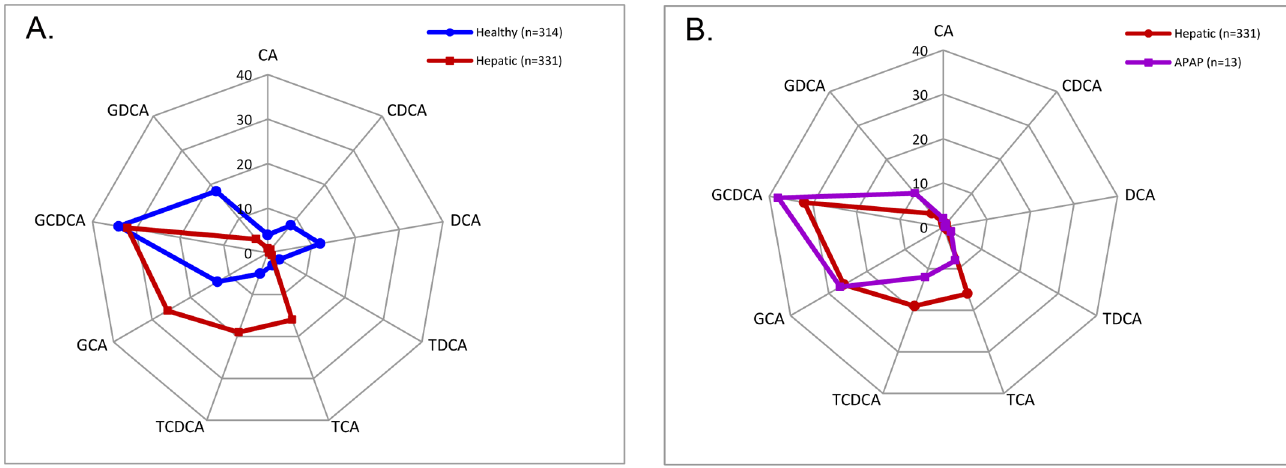
Fig 3. Serum bile acid composition changes among healthy, hepatic injury, and drug-induced liver injury (DILI) subjects. (A) Bile acid pattern comparisons between healthy and hepatic injury subjects demonstrated differences between the two groups. (B) Slight differences in the bile acid patterns of APAP overdosed patients (DILI) and all hepatic injury subjects were observed. Numbers were expressed as a percent of the total individual bile acids measured.